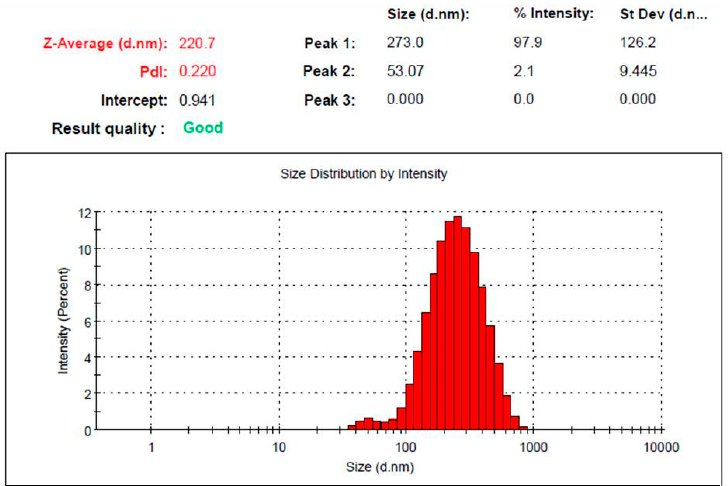
Figure 1. Vesicular size and size distribution curve of colchicine loaded niosome.